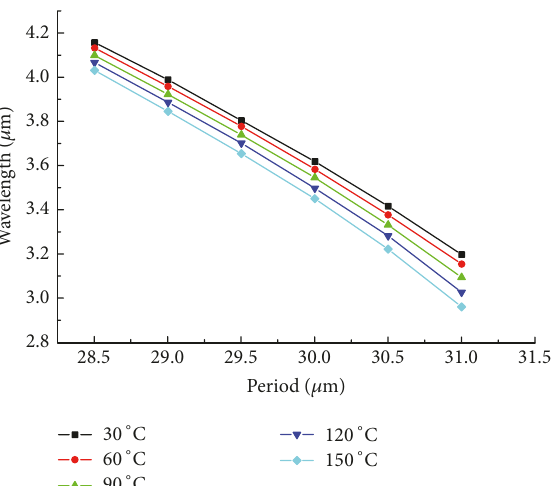
Figure 3: The idler output power versus incident pump power with different domain period ( 𝑇 = 30 ∘ C).